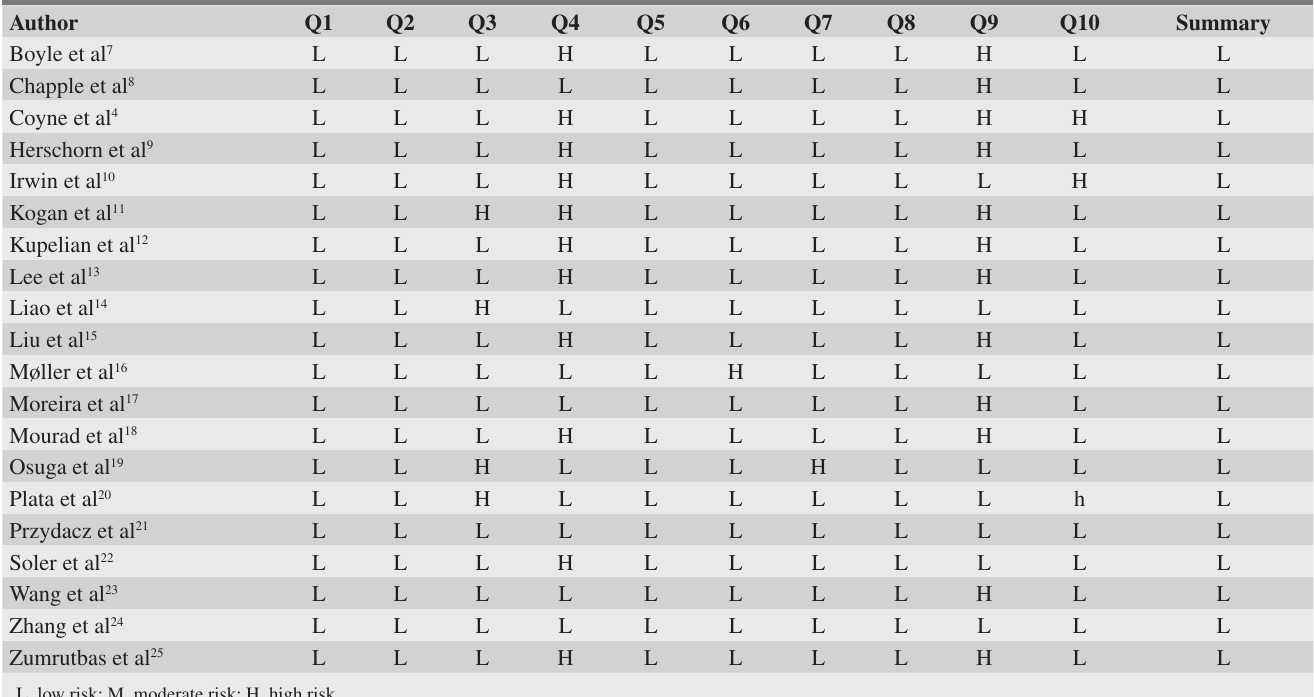
Table 1. Quality Assessment for Prevalence Studies